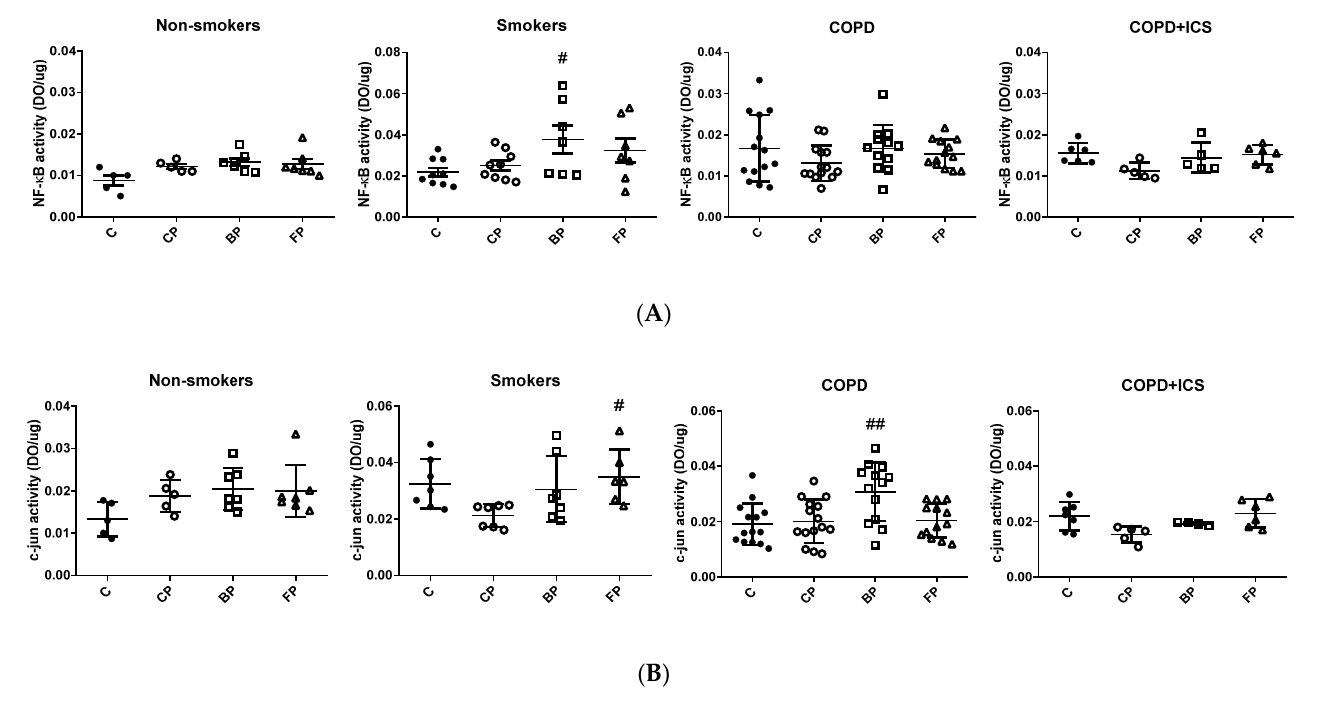
Figure 3. NF- κ B ( A ) and c-jun ( B ) activity in alveolar macrophages: NS, nonsmoker; COPD, chronic obstructive pulmonary disease; COPD + ICS, chronic obstructive pulmonary disease with inhaled corticosteroids use; C, control; CP, stimulated with Pseudomonas aeruginosa ; BP, stimulated with Pseudomonas aeruginosa and budesonide (BUD); FP, stimulated with Pseudomonas aeruginosa and fluticasone propionate (FLU). n = 6–8 per group; two-way ANOVA, Bonferroni’s post hoc; # p < 0.05 and ## p < 0.01 vs. CP. C: ● ; CP: ○ ; BP: □ ; FP: Δ .